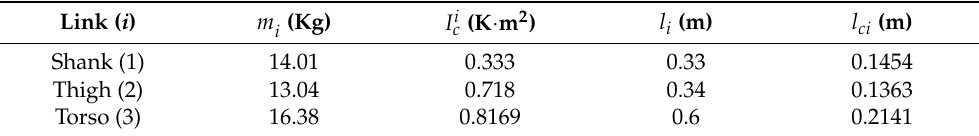
Table 1. Inertial robot parameters.